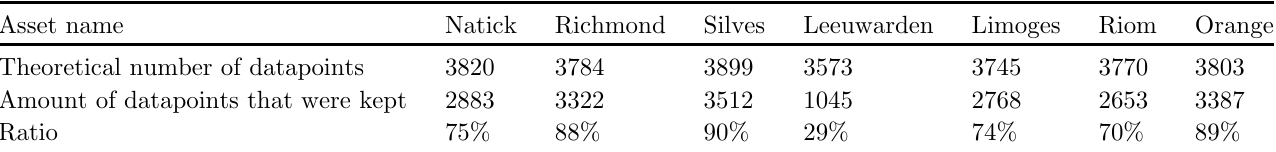
Table 3. For each asset, amount and percentage of data points that were kept, over the six months of benchmark, after cleaning of the data. Asset name